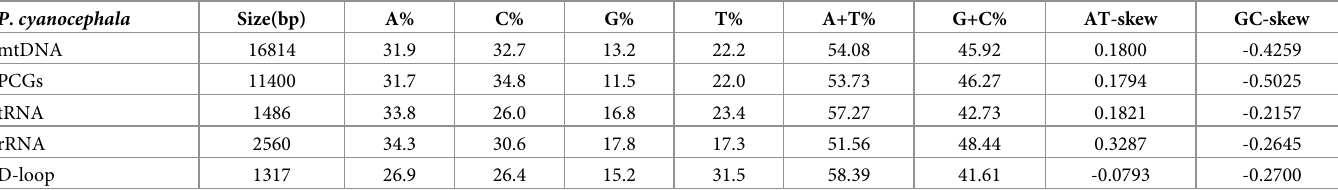
Table 3. Nucleotide composition and skew values for Psittacula cyanocephala mitogenome. P . cyanocephala